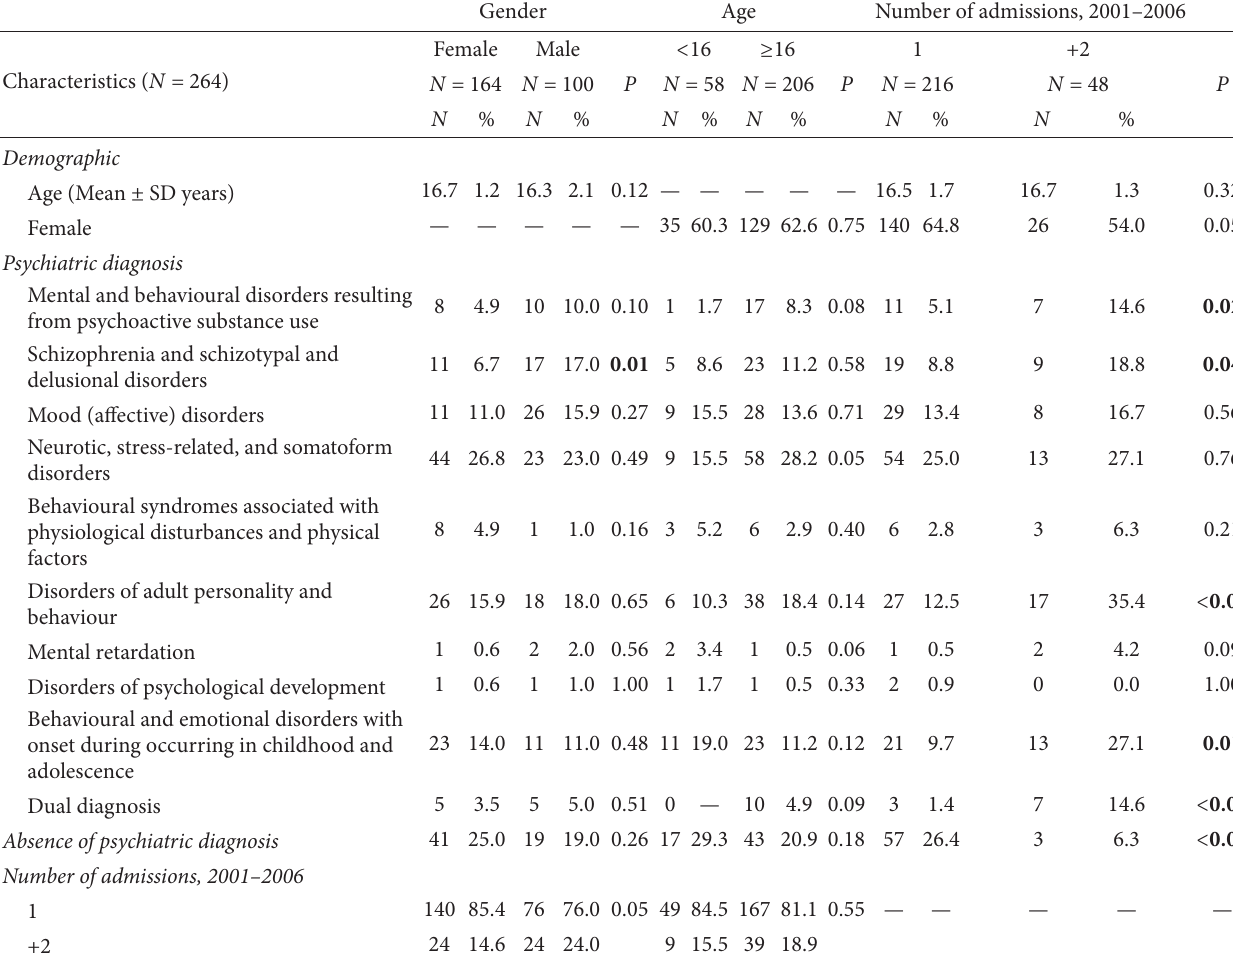
T 3: Characteristics of child and adolescent patients in a psychiatric emergency department of a French public hospital (2001–2006) by gender, age and number of